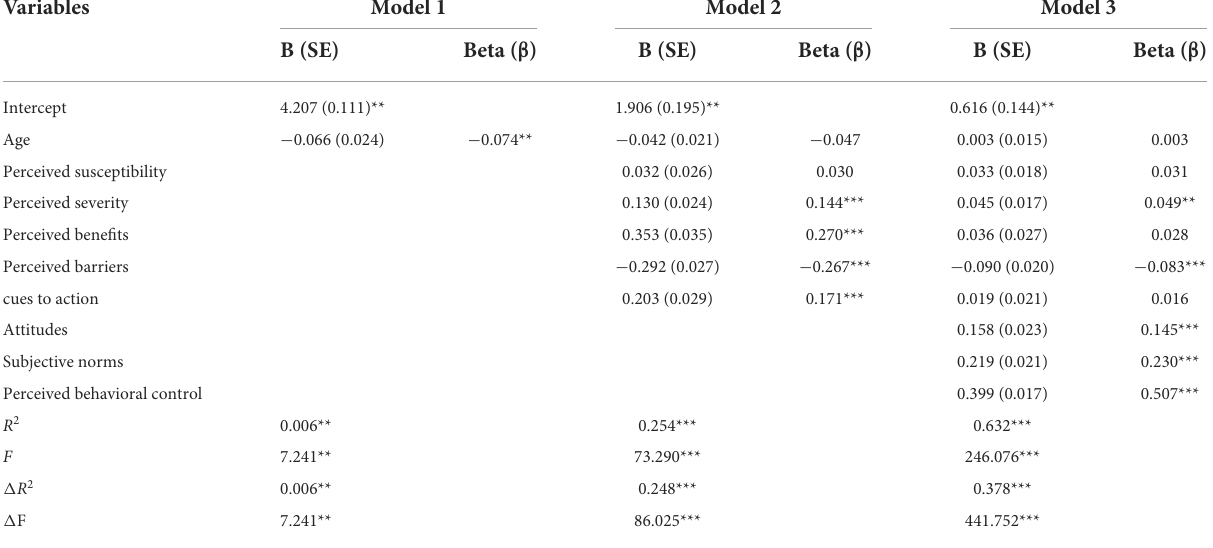
TABLE 3 Hierarchical multiple regression analysis including age, HBM variables and TPB